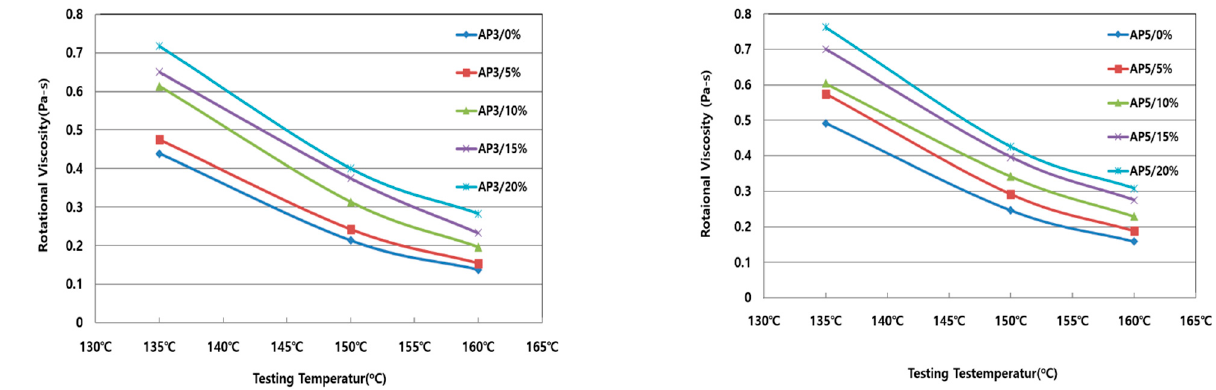
Figure 4. Rotational viscosity with pyrolysis carbon black.